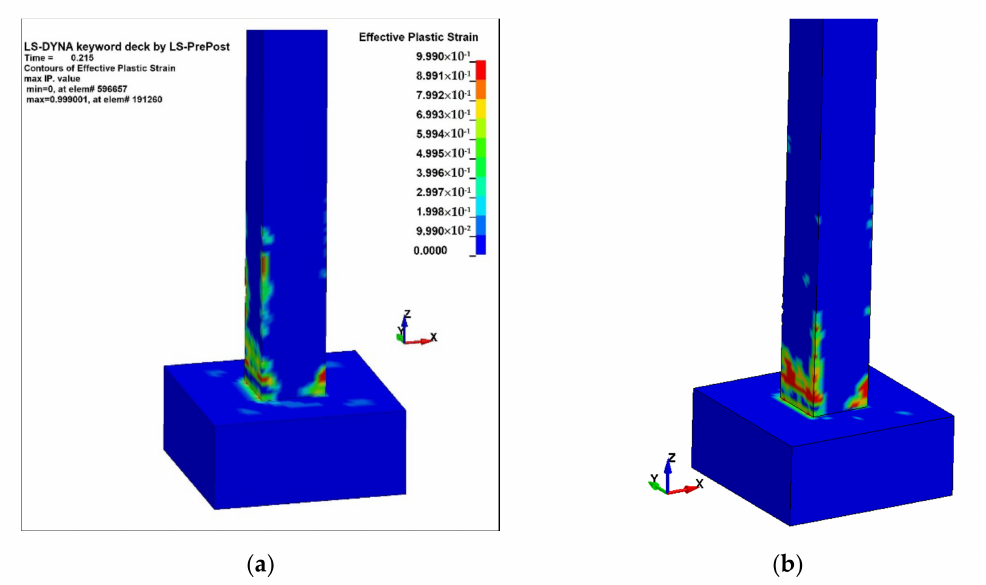
Figure 9. Column (C300) damage contour for car impact velocity of V = 40 km/h: ( a ) impacted by Econoline and ( b ) Explorer.